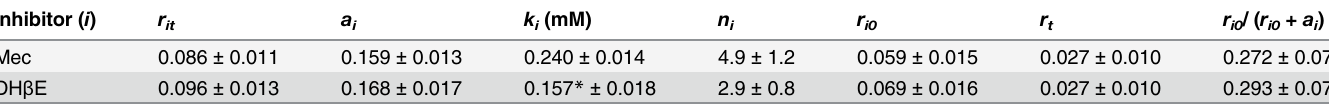
Fig 3. Effect of varying concentrations of DH β E or Mec on the CT response to nicotine in rats. (A) This is a representative normalized CT response in a rat in which the tongue was first rinsed with distilled H 2 O (R) and then stimulated with 10 mM nicotine solutions containing 0 – 0.5 mM DH β E or 0.3 mM DH β E + 0.4 mM Mec. (B) This is a representative normalized CT response in a rat in which the tongue was first rinsed with distilled H 2 O (R) and then stimulated with 10 mM nicotine solutions containing 0 – 0.5 mM Mec or 0.4 mM Mec + 0.3 mM DH β E. (C) Display of the mean normalized tonic CT responses ( N = 3) to 10 mM nicotine in the presence of increasing concentrations (0 – 0.5 mM) of Mec (c Mec ; ● ) or DH β E (c DH β E ; (cid:3) ). The solid line is the least squares fit of Eq 2 to the Mec data set and the broken line is the fit to the DH β E data set. The least squares fit parameter values are shown in Table 2.